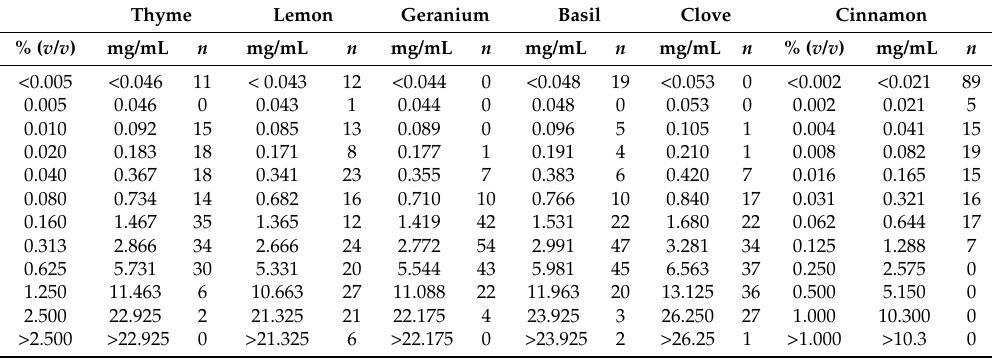
Table 2. Number of isolates with exact MFC value of the selected essential oil in the group of 183 C. albicans clinical isolates.